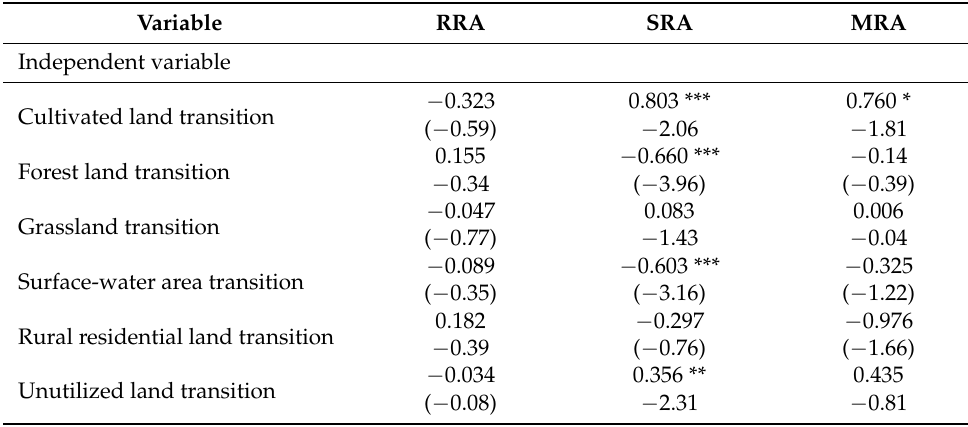
Table 3. Summary of regression